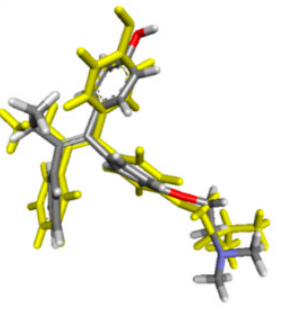
Figure 3. Binding poses of 4-OHT as co-crystalized ligand (yellow) and re-docked native ligand (atomic coloring).